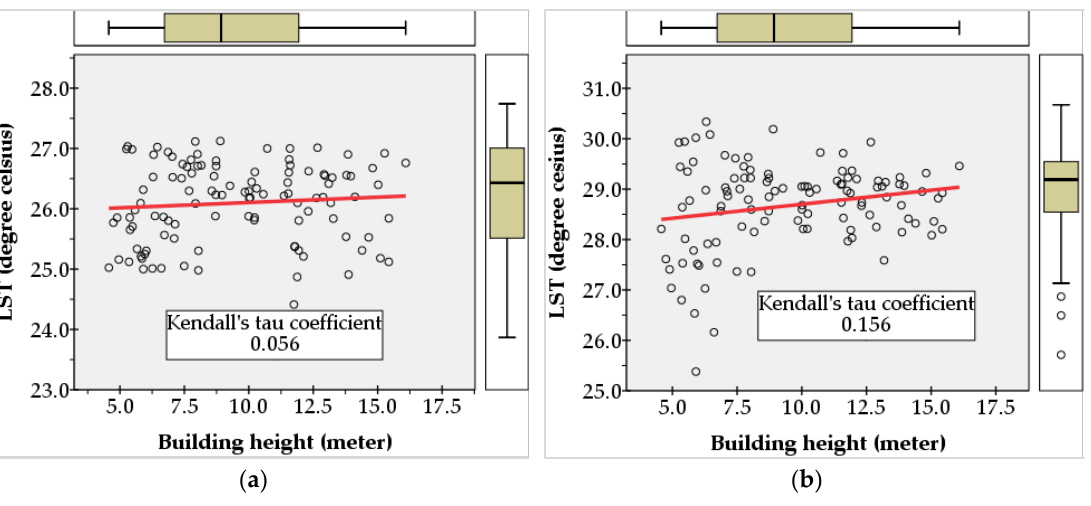
Figure 18. Relationship between ( a ) building height and summer LST, ( b ) building height and winter LST where the Y-axis shows LST in degree Celsius, X-axis shows building height, and the red line is the slope of the correlation coefficient. Remote Sens. 2019 , 11 , x FOR PEER REVIEW